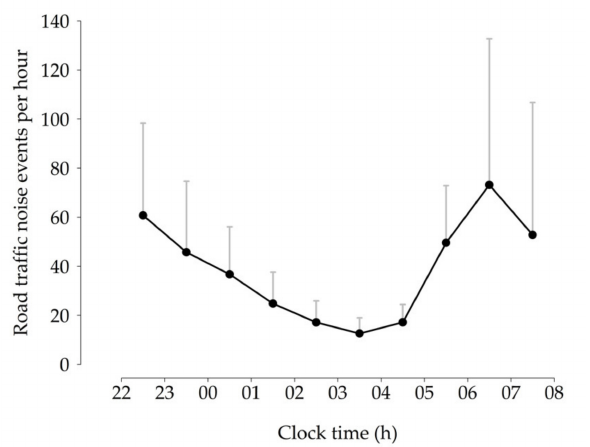
Figure 1. Hourly distribution of road traffic noise events during participants’ time in bed based on data provided by a traffic counter. Vertical lines correspond to standard deviations. The number of events per night were averaged within and across participants (N =